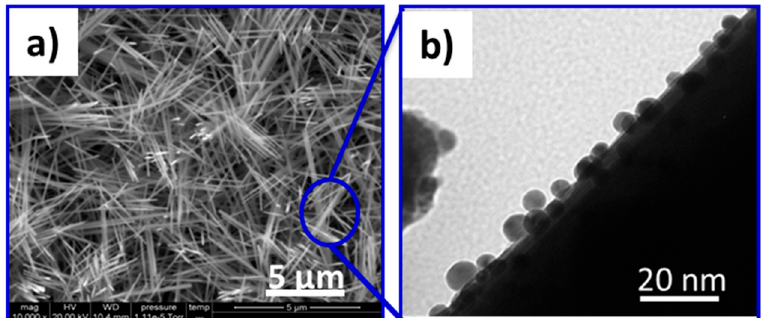
Figure 2. ( a ) SEM images of the as-deposited films of Pt-nanoparticles decorated tungsten oxide nanoneedle-like nanowires (Pt/WO 3 ); ( b ) PtNPs on the surface of nanowires.